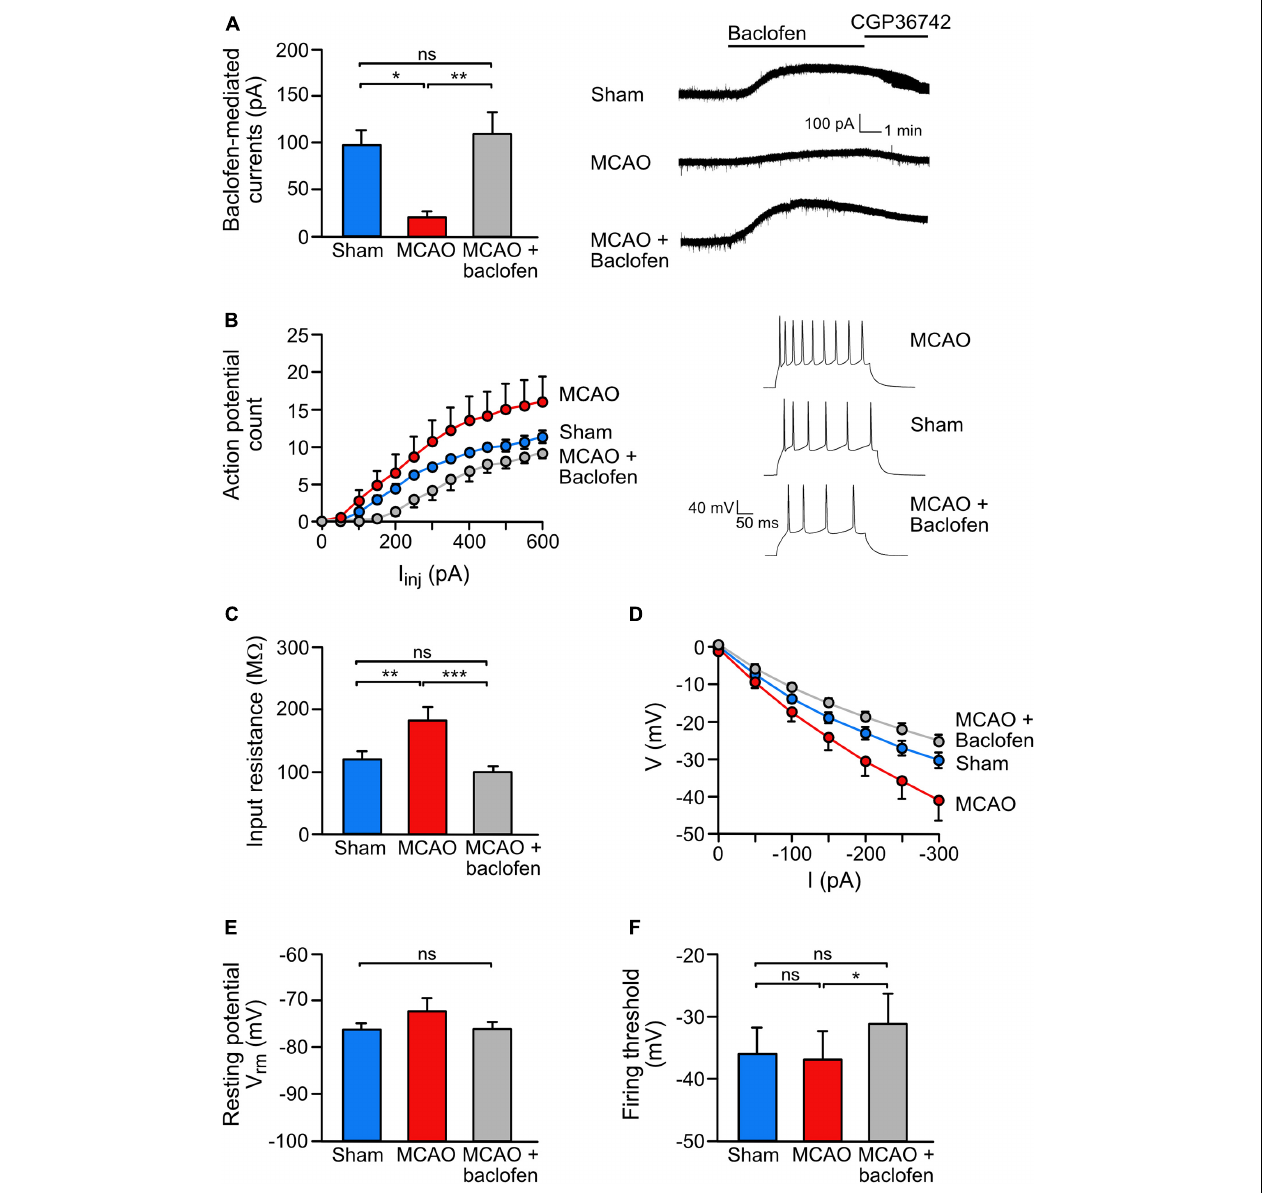
FIGURE 5 | Baclofen treatment rescued the ischemia-induced reduction of GABA B receptor-mediated currents and reduced neuronal hyperexcitability. (A) Baclofen treatment normalized GABA B mediated currents in the ischemic brain. Coronal brain sections obtained from sham or MCAO treated mice were recorded ex vivo within 3–6 h after baclofen or saline injection injection. Mice were sacrifized for slice perparation 1 h after baclofen or saline injection. Baclofen-induced currents were measured for a duration of 15 min using whole cell voltage clamp recordings. Right, representative voltage clamp traces. One-way ANOVA with Tukey’s Multiple Comparison post hoc test (ns, p > 0.5; *, p < 0.05; **, p < 0.01). (B) Baclofen injection reduced ischemia-induced neuronal hyperexcitability. The experimental conditions were the same as in panel (A) except that recordings were obtained in the current clamp mode. Neurons of MCAO-treated mice show an increased intrinsic excitability reflected by an increased number of action potentials elicited by a series of depolarizing current pulses (50 pA/250 ms from resting membrane potential). Repeated measures ANOVA with mixed-effects analysis showed a significant interaction among AP counts and treatments [ F (1.226,135.4) = 35.23, p < 0.0001). Right, representative current clamp traces elected by 300 pA current pulse. (C–F) Baclofen reduced excitability by modulating intrinsic neuronal properties. (C) While MCAO increased the input resistance, treatment with baclofen reduced the values to sham levels. This effect was calculated from the slope of I–V curves (D) . One-way ANOVA with Tukey’s Multiple Comparison post hoc test (ns, p > 0.05; **, p < 0.01; ***, p < 0.001). (E) The analysis revealed no change in the resting membrane potential and no change in the neuronal firing threshold in MCAO mice. However, treatment with baclofen depolarized the action potential firing threshold in MCAO mice. One-way ANOVA with Tukey’s Multiple Comparison post hoc test (ns, p > 0.05; *, p < 0.05). The data represent the mean ± SEM for the number of cells/mice: sham = 19/6, MCAO = 16/5, R1 = 9/4, Rand = 11/5.